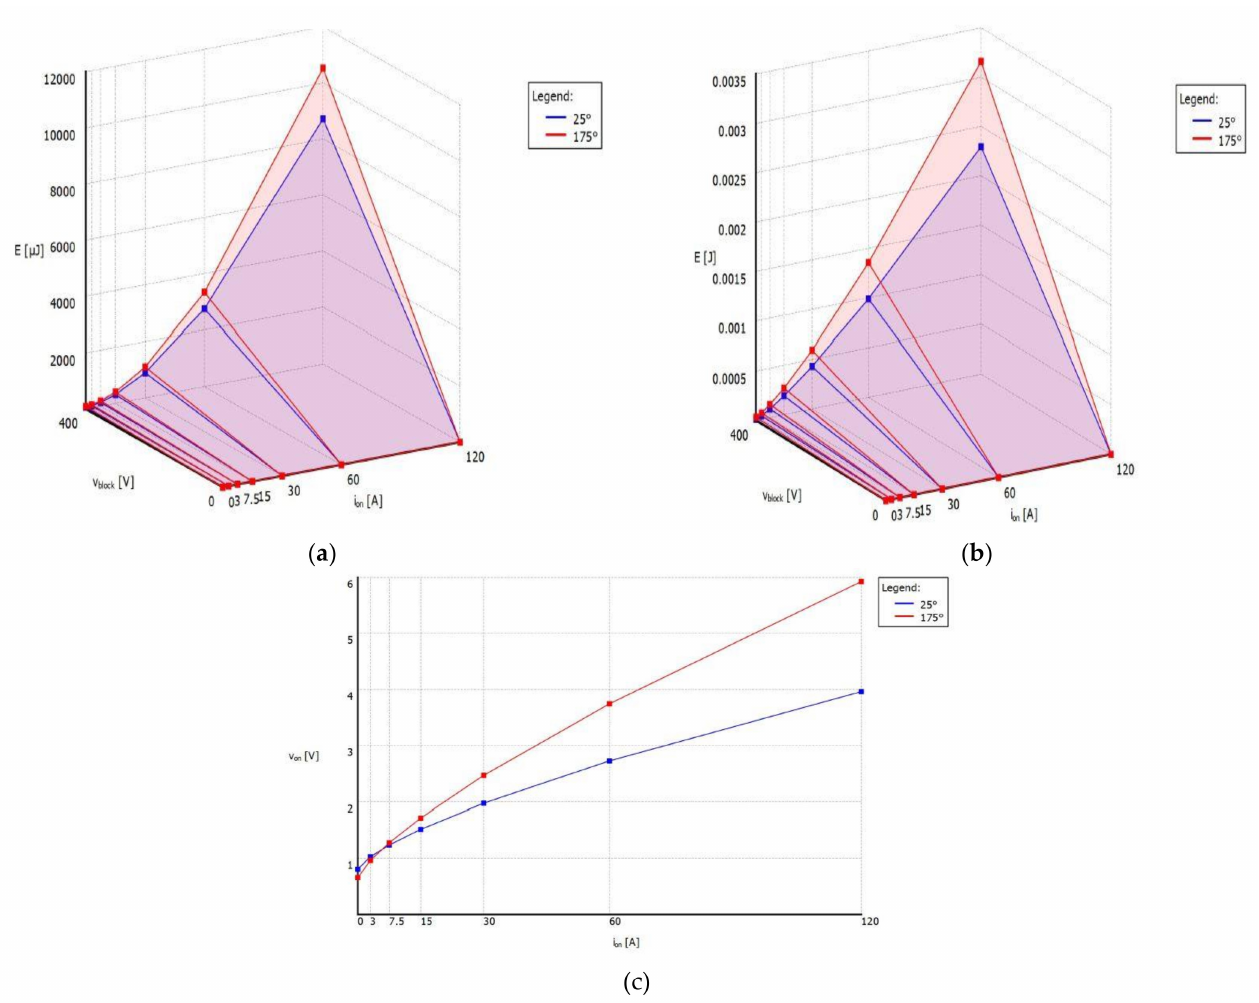
Figure 6. ( a ) Turn on loss, ( b ) turn off loss, and ( c ) conduction